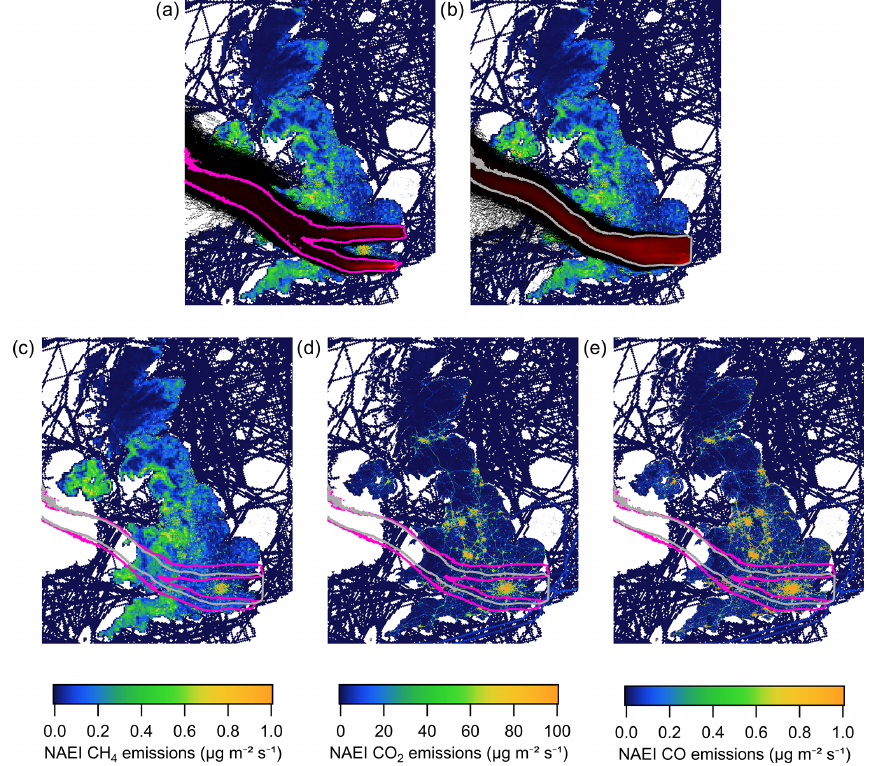
Figure 4. NAME air histories aggregated over (a) background sampling periods and (b) in-plume sampling periods, overlaid on an NAEI emissions inventory map for CH 4 (shown using a saturated colour scale). Both air histories have been normalised such that they sum to 1, with grey and pink contours shown in each plot surrounding the vast majority (99.9995%) of sample influence. These contours are included in panel (c) , (d) and (e) to provide a better visual comparison between the two aggregate air histories in the context of the inventory emissions for CH 4 , CO 2 and CO respectively. Table 1. Background mole fractions for each species to the north and the south of the London plume, calculated using the flux-dispersion method. CO (ppb) CH 4 (ppb) CO 2 (ppm) Dataset Altitude (m) South North South North South North Measured 287 148.4 146.6 1943.1 1940.7 409.6 409.1 149.2